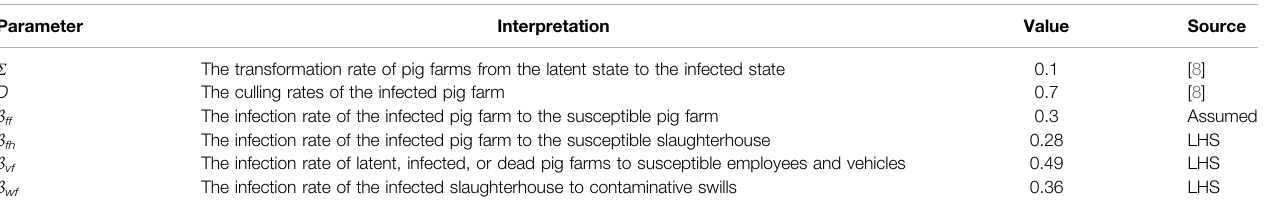
TABLE 2 | Descriptions and values of the parameters in the